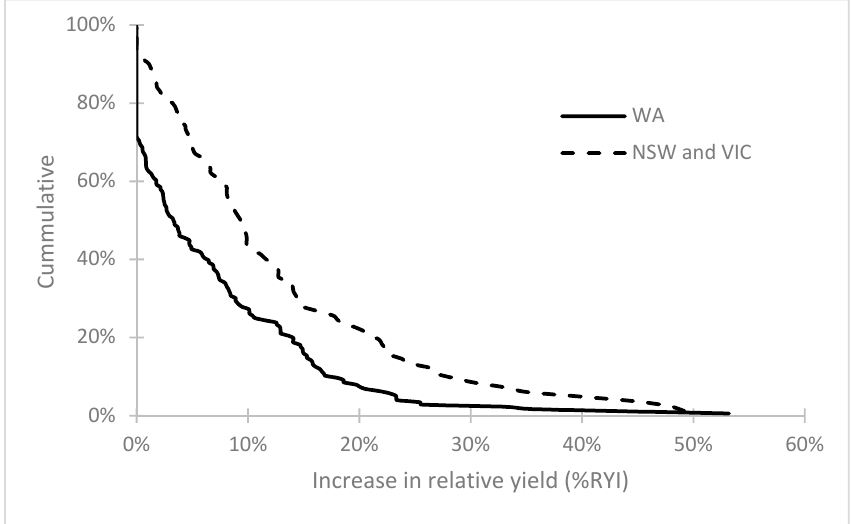
Figure 2. Frequency of relative yield increase after one or more year of lime applied for WA, NSW and VIC.